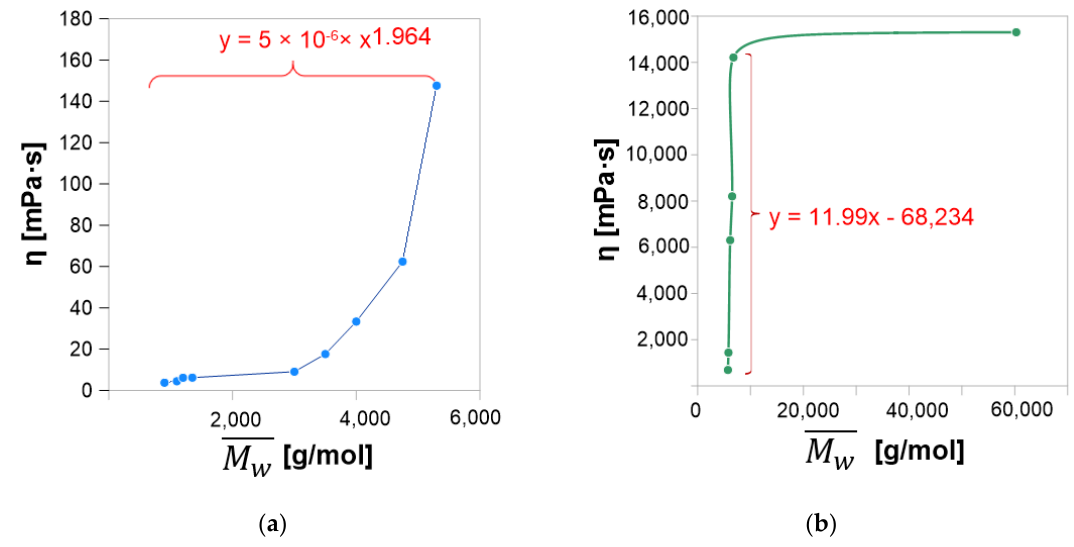
Figure 7. Change of viscosity and weight-average molar mass of the reaction mixture during the polyaddition process conducted in the bulk via the fusion method: ( a ) ESBO_BPA and ( b ) SMEG_EPR.